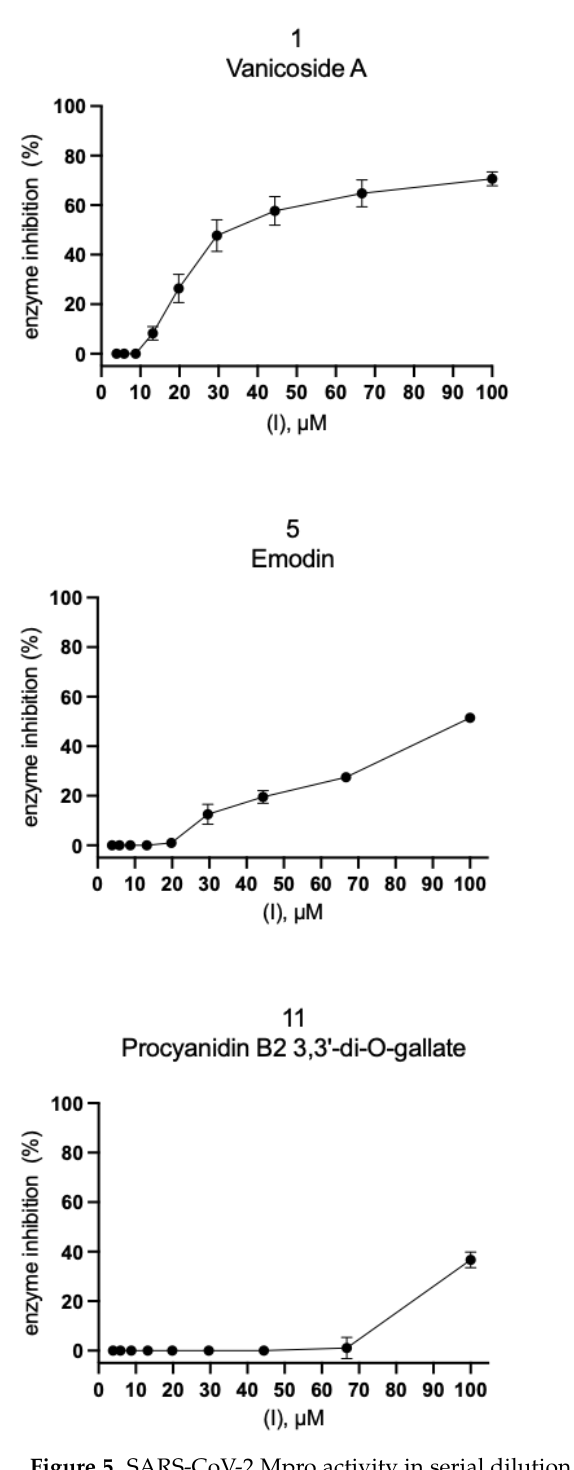
Figure 5. SARS-CoV-2 Mpro activity in serial dilution of compounds. The results were presented as SARS-CoV-2 Mpro inhibition (%).